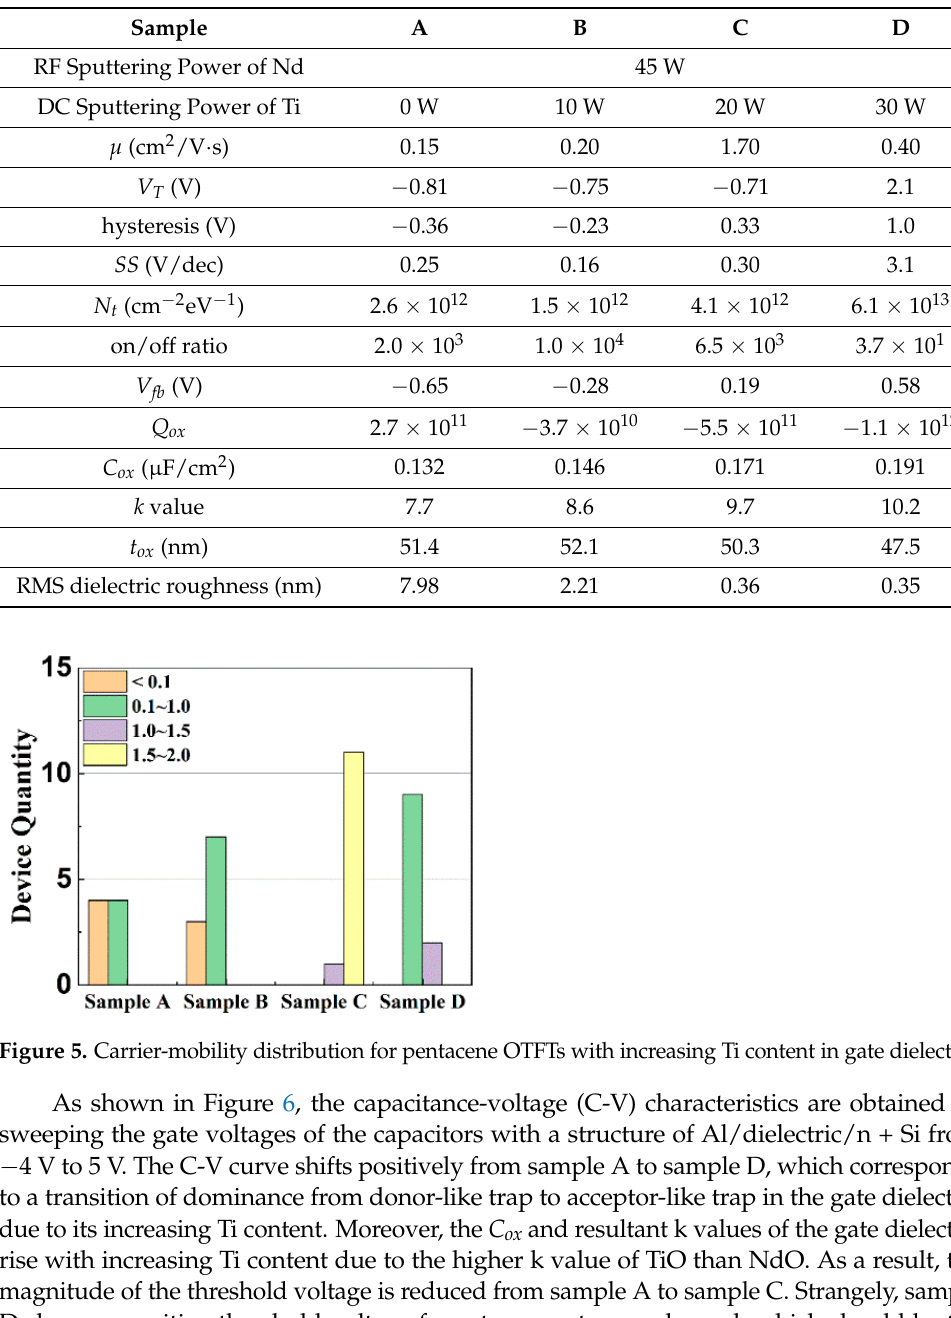
Table 1. Main electrical parameters of OTFTs with increasing Ti content in gate dielectric.